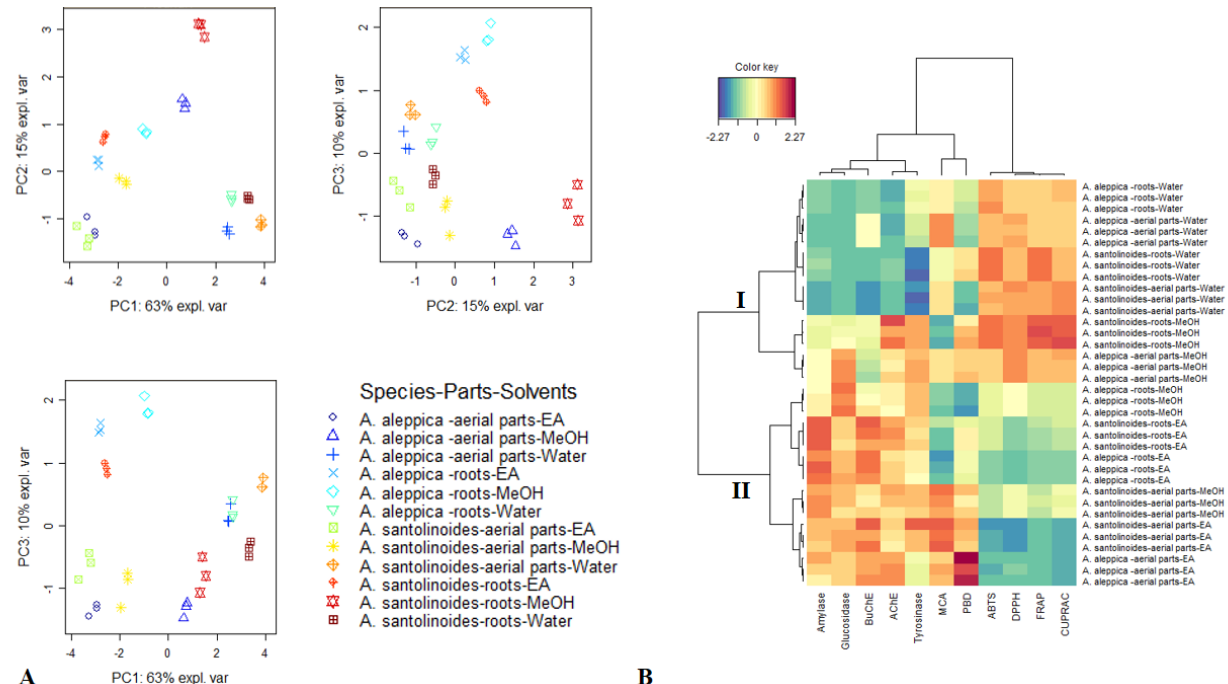
Figure 4. Exploratory multivariate analysis on biological activities of Achillea species. ( A ). Score plots of principal component analysis. ( B ). Clustered Image Map ( Red color: High activity, Blue color: low activity